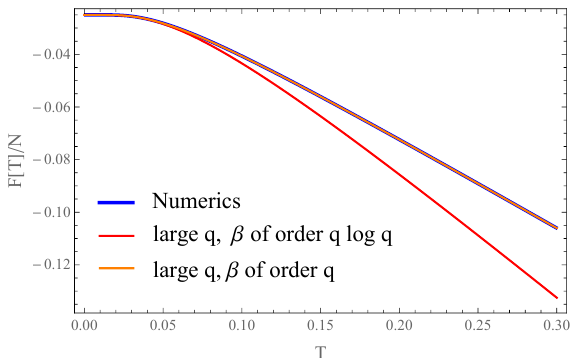
= 1 and (cid:22) = 0 : 1. J